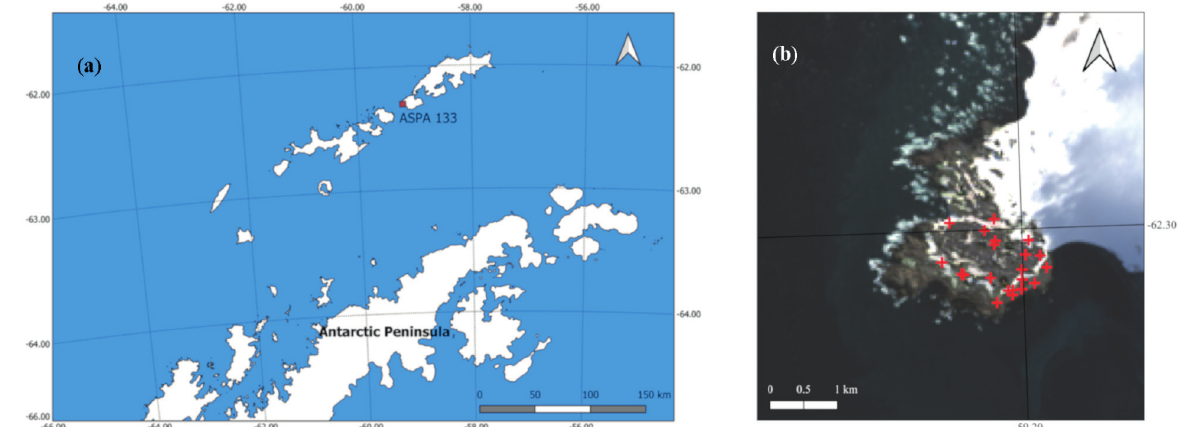
Figure 1. Study area location. The ASPA 133 location in relation to the Antarctic Peninsula (a) and samples points over Harmony Point in Nelson Island